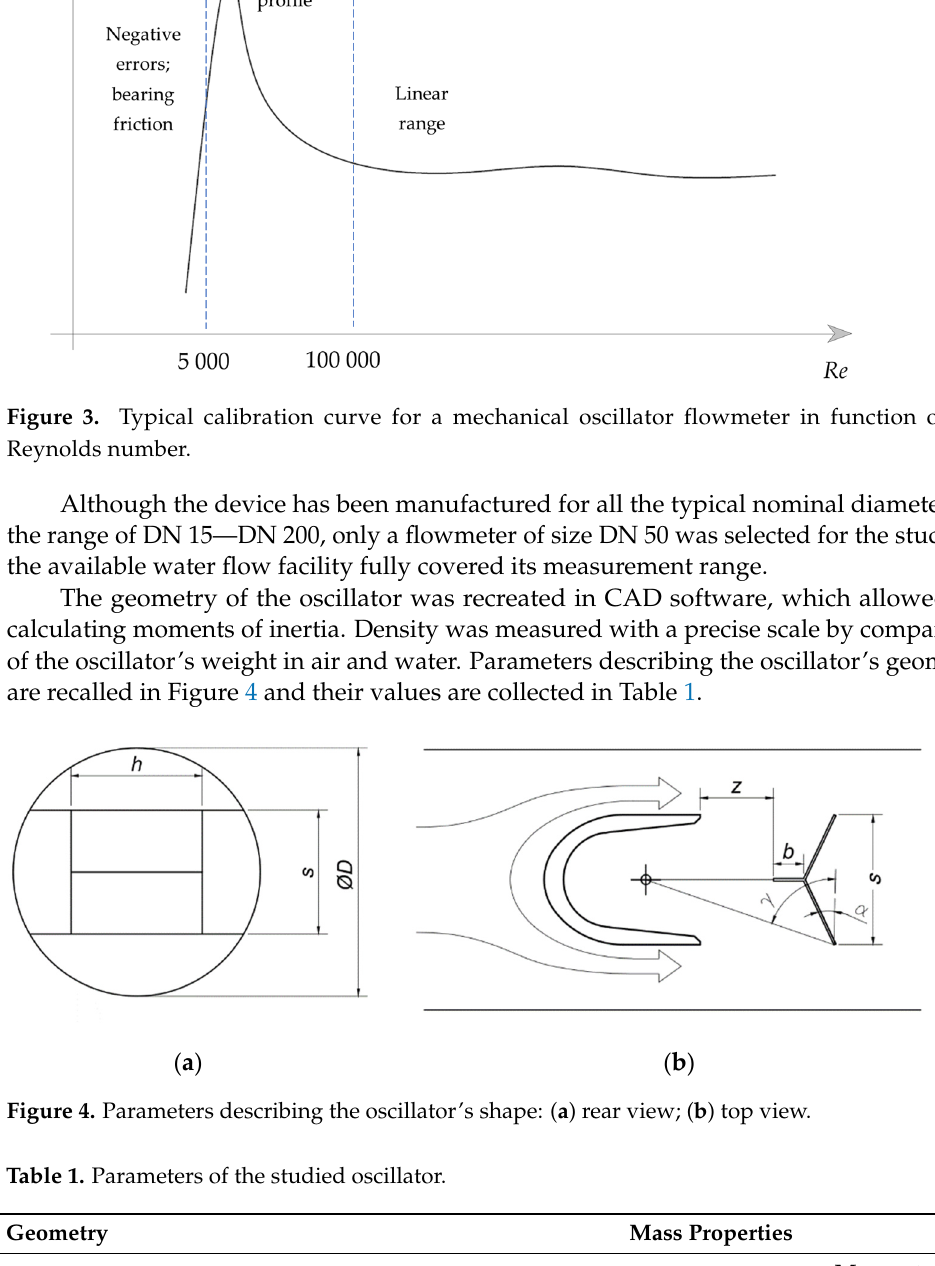
Figure 3. Typical calibration curve for a mechanical oscillator flowmeter in function of the Reynolds number.